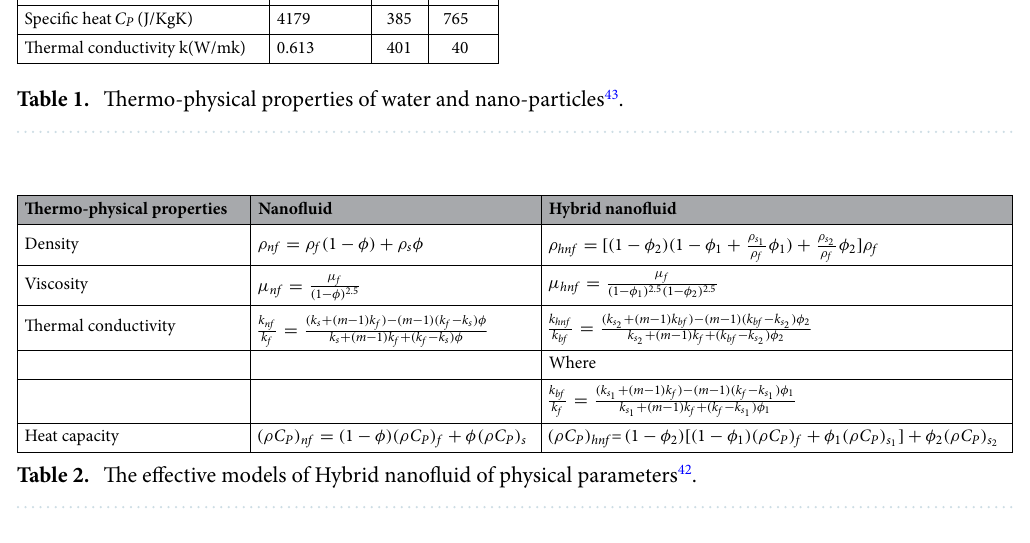
Thermo-physical properties